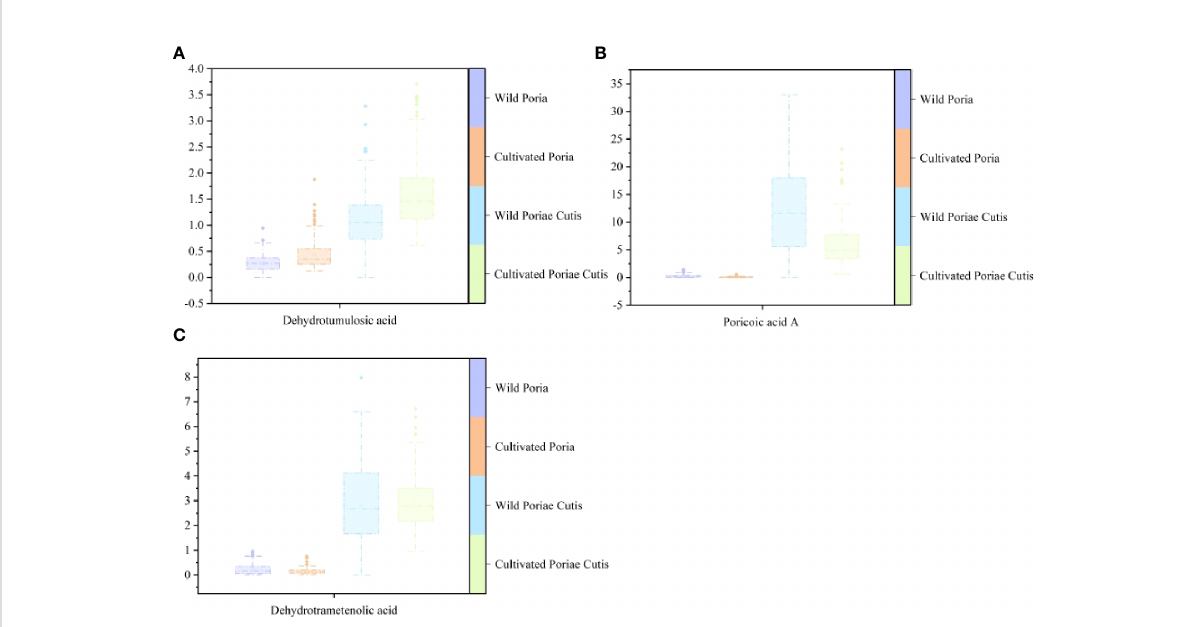
FIGURE 5 Box-plots based on contents of three triterpene acids of wild and cultivated W. cocos in different parts: (A) dehydrotumulosic acid, (B) poricoic acid A, and (C) dehydrotrametenolic